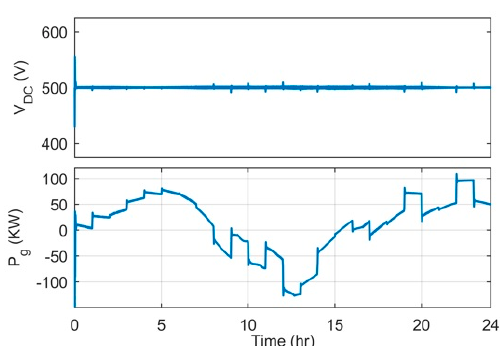
Figure 12. Performance of the PV system.